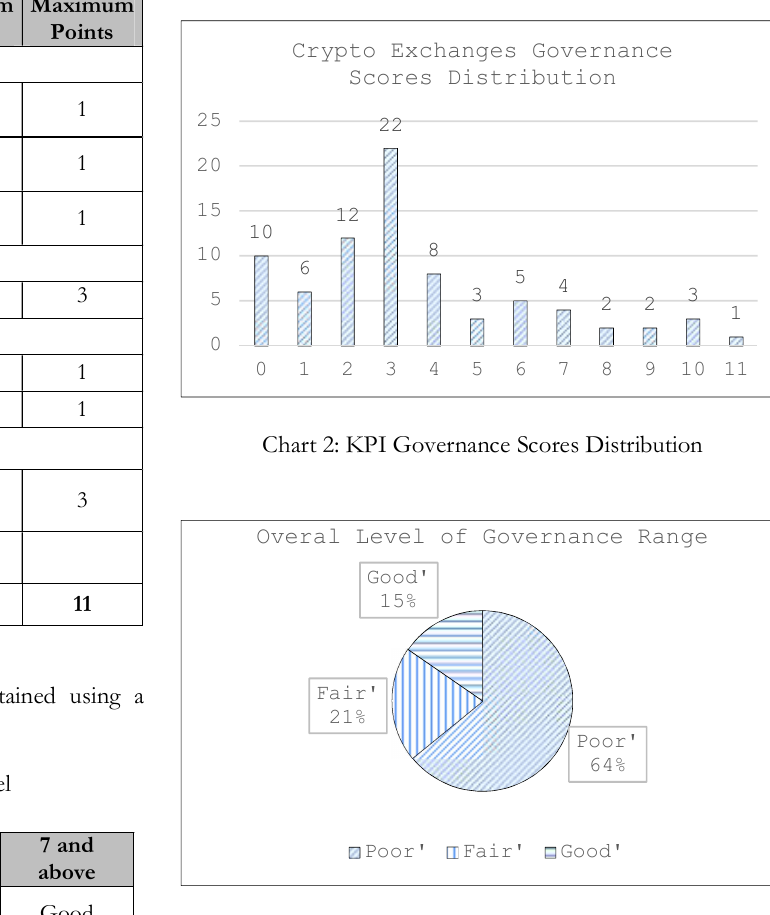
Chart 3: KPI Governance Scores